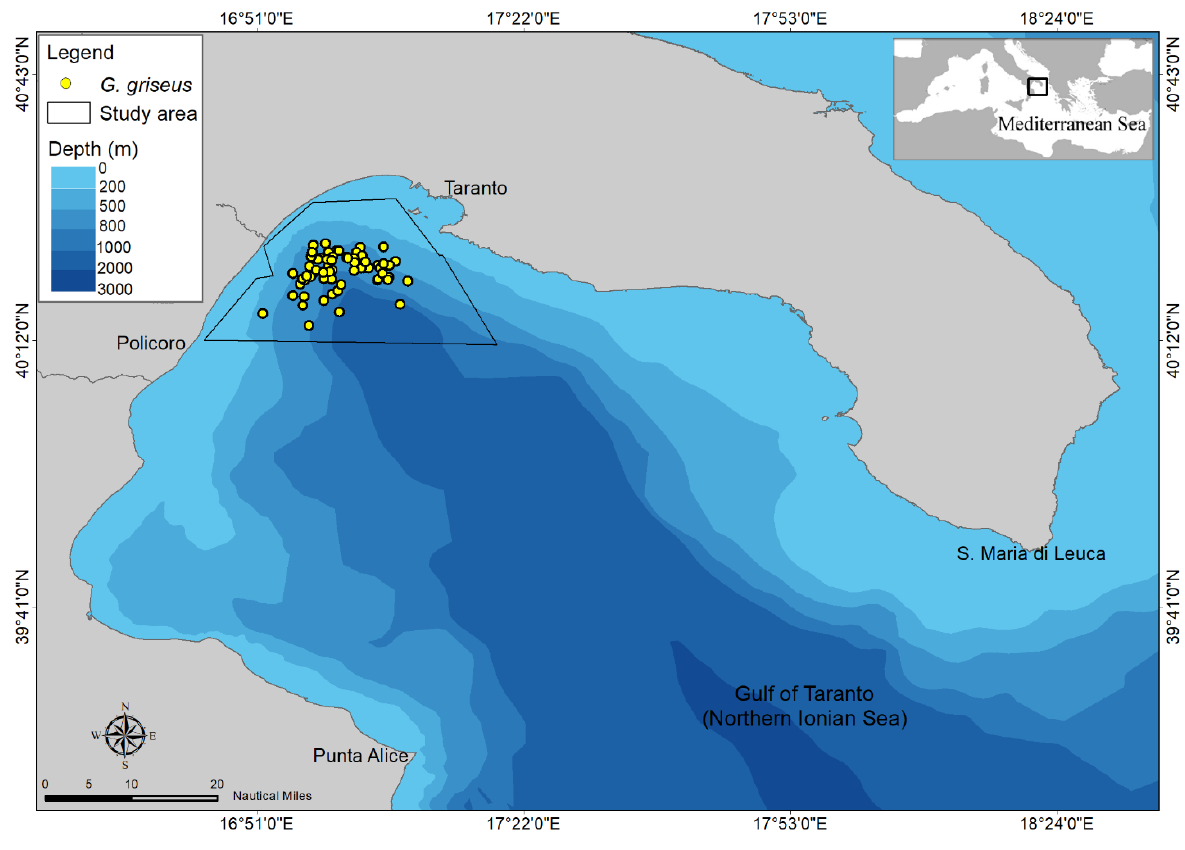
Figure 2. Map of the Gulf of Taranto (Northern Ionian Sea, Central-eastern Mediterranean Sea) with indication of sightings of Risso’s dolphin and the study area investigated in 2019– 2021.